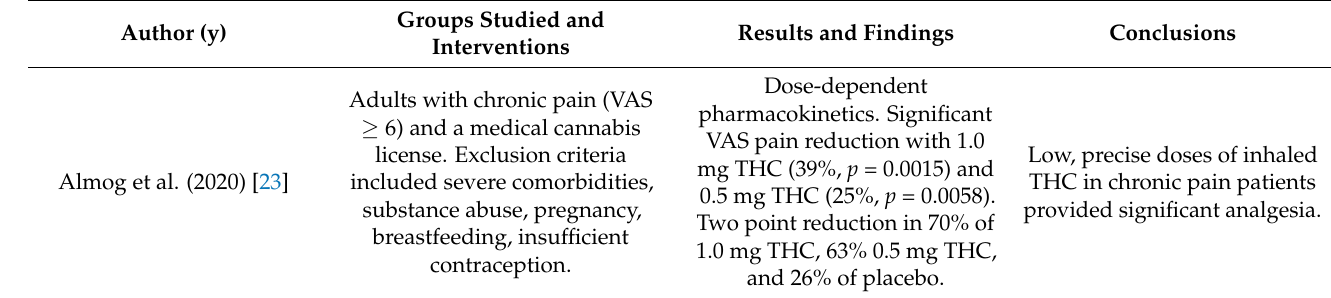
Table 1. Studies on chronic pain and